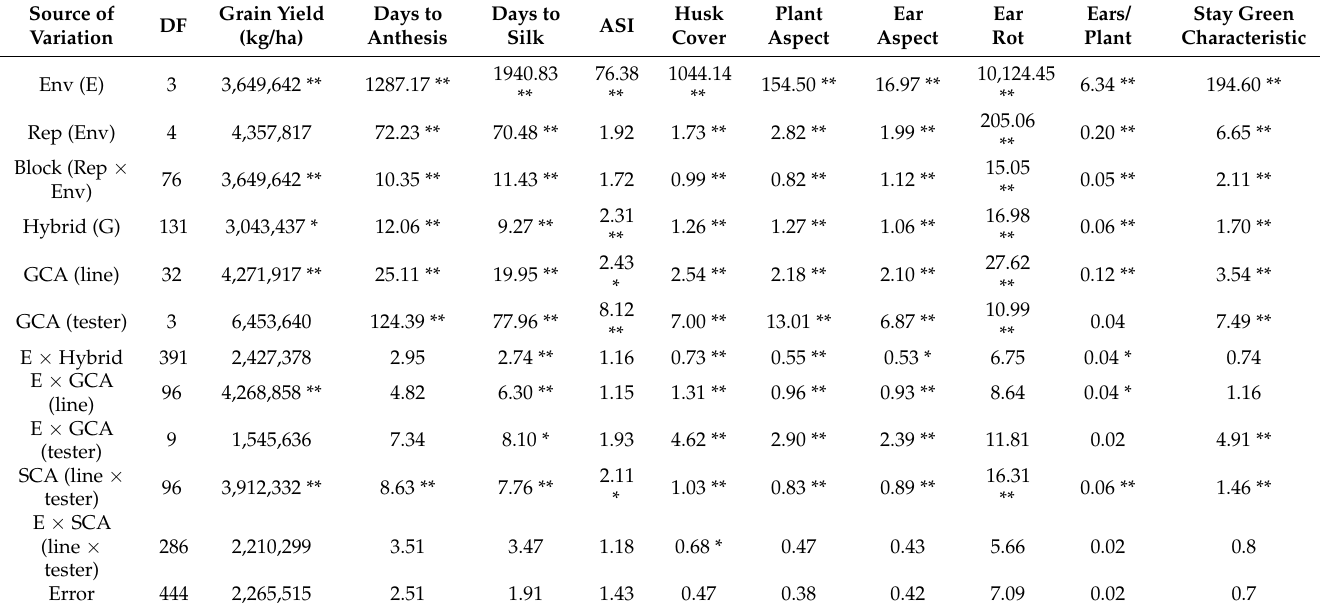
Table 3. Mean squares from the line × tester analysis of variance of grain yield and other traits of 132 hybrids evaluated across drought at four locations in Nigeria during the 2015 and 2016 growing seasons.